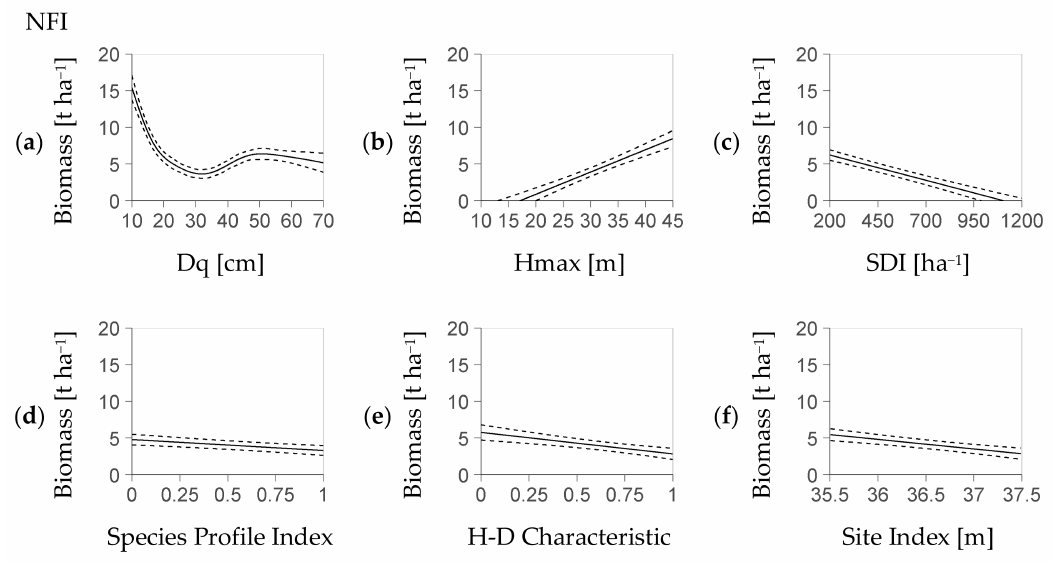
Figure 1. Profiles of regeneration biomass as predicted by the deterministic model part based on the NFI (German National Forest Inventory, Equation (4a)). Each profile is presented over one predictor with, at the same time, the remainder predictors at their mean value (abbreviation H-D: Height-Diameter); profiles ordered by the relevance of the referring predictor based on the AIC criterion (( a – f ), see Section 2.4); dotted lines refer to the confidence interval; each predictor shown within its 95% interval; the stochastic part (Figure 3a,b) covers the residual